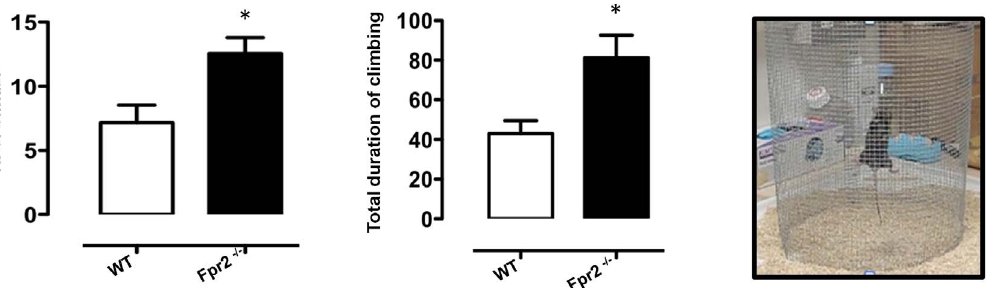
Fig. 2. Increased exploratory behaviour of Fpr2/3 -/- mice in the climbing test. The bar graphs show the number of climbing events and total time (seconds) spent on the climbing mesh during a 5-minute trial. Values are expressed as median ¡ S.E.M. and representative of three different experiments, each involving 6–9 mice per group. * P , 0.05 indicate significant values compared with wild-type (WT) control mice (Mann–Whitney U